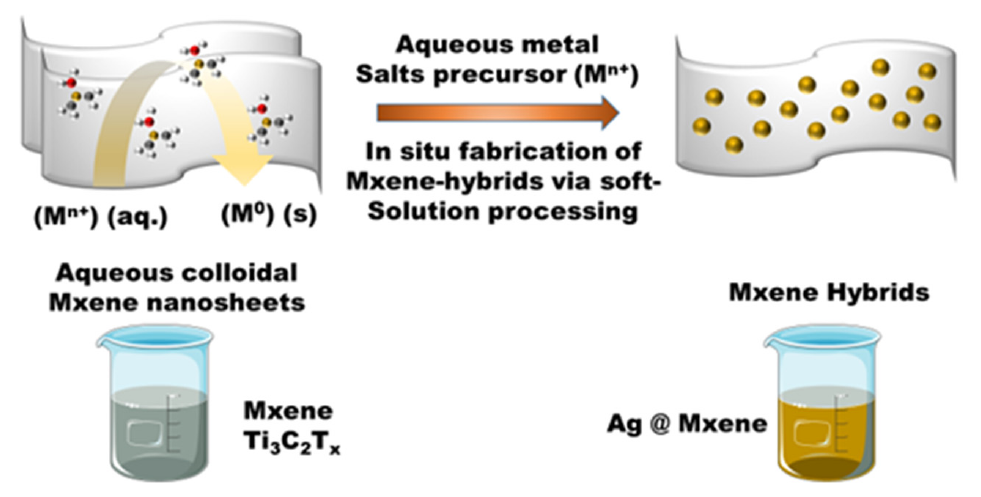
Figure 1. The structural schematic of the proposed hybrid metal–graphene material, and the parameters of the proposed unit structure.